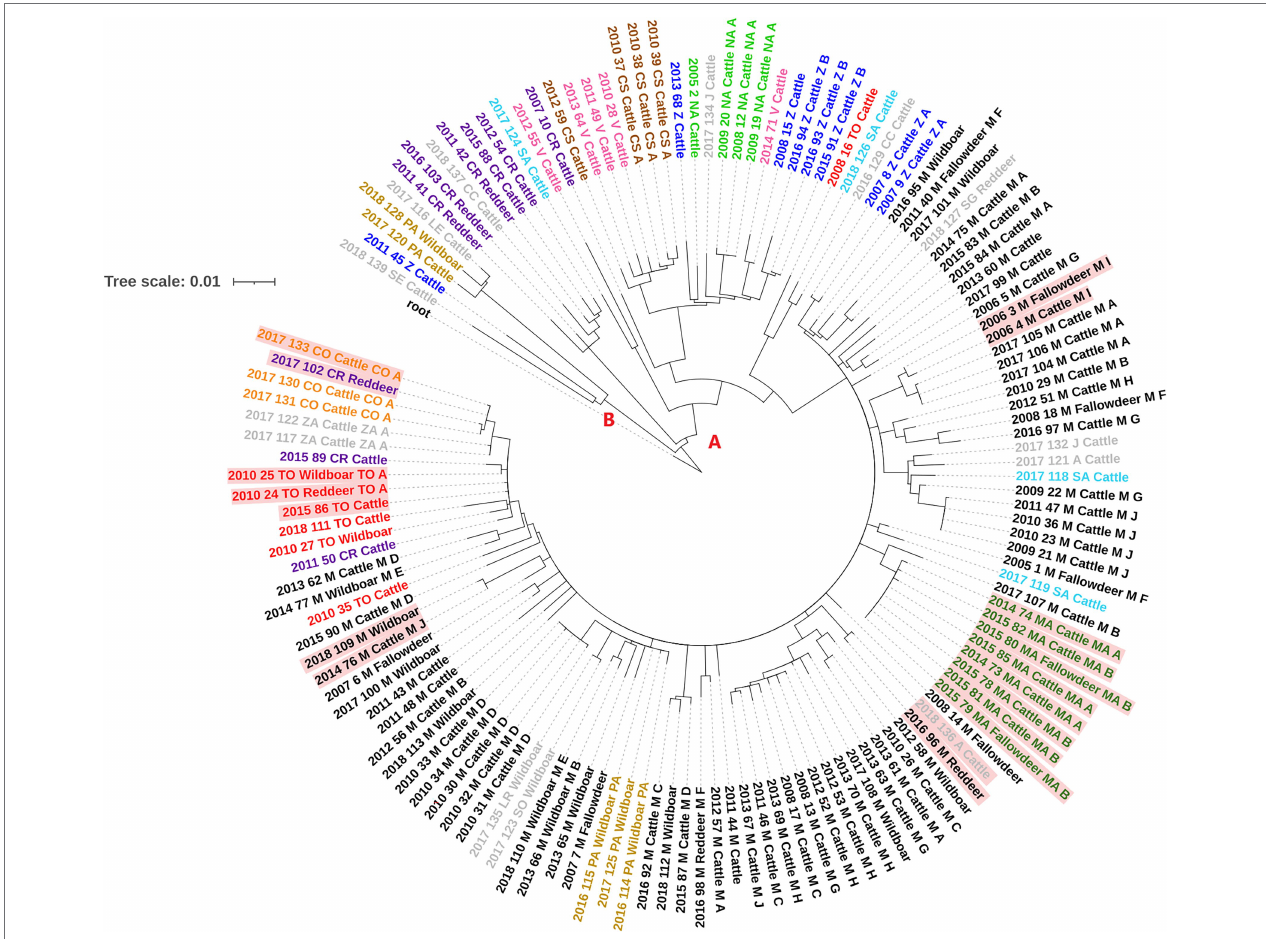
FIGURE 2 | Whole-genome sequence RAxML phylogenetic tree constructed using a GTR-CAT model of 136 Spanish M. bovis SB0339 samples. The two distantly related groups of isolates are indicated with letters A and B. Isolate tags are colored based on the province of isolation which codes are shown in Table 1 . Isolates with genetic distances of ≤ 3 SNPs between cattle and wildlife are colored in red